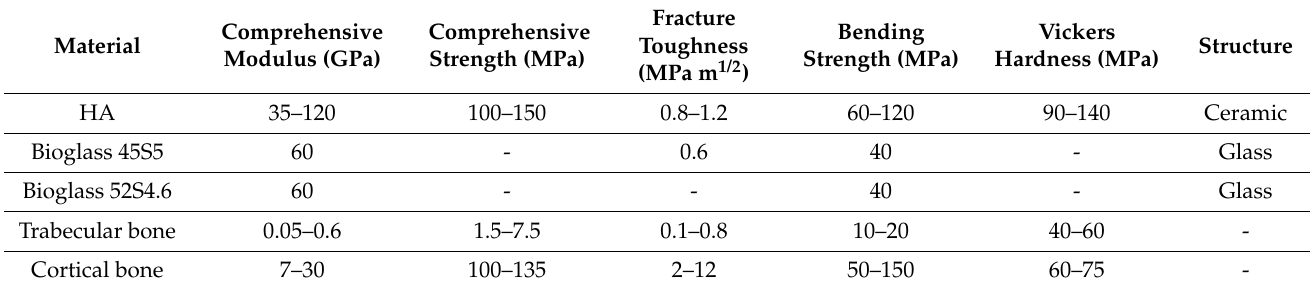
Table 2. Mechanical properties of bioglass, ceramics, and human bones